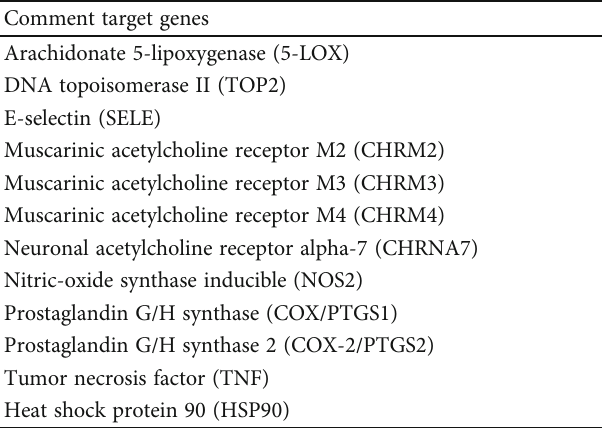
Figure 4: Protein interaction network of active ingredient in PRA. Table 4: Common target genes of PRA and